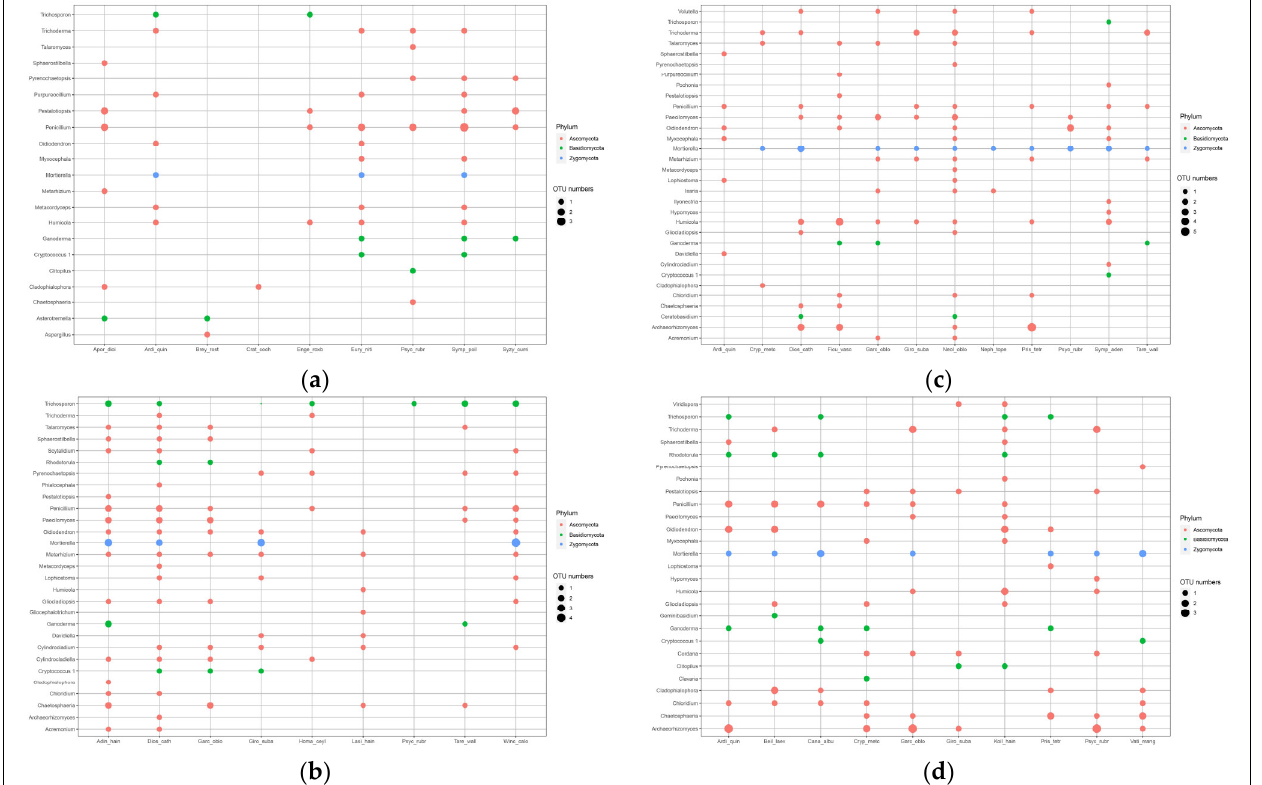
Figure 4. Fungi genera associated with plants. The different colors indicate fungal taxonomy at phylum level. ( a – d ) represent SB (slash-and-burn), CC (clear cutting), SL (selective cutting) and OG (old growth forests) forest stands, respectively.